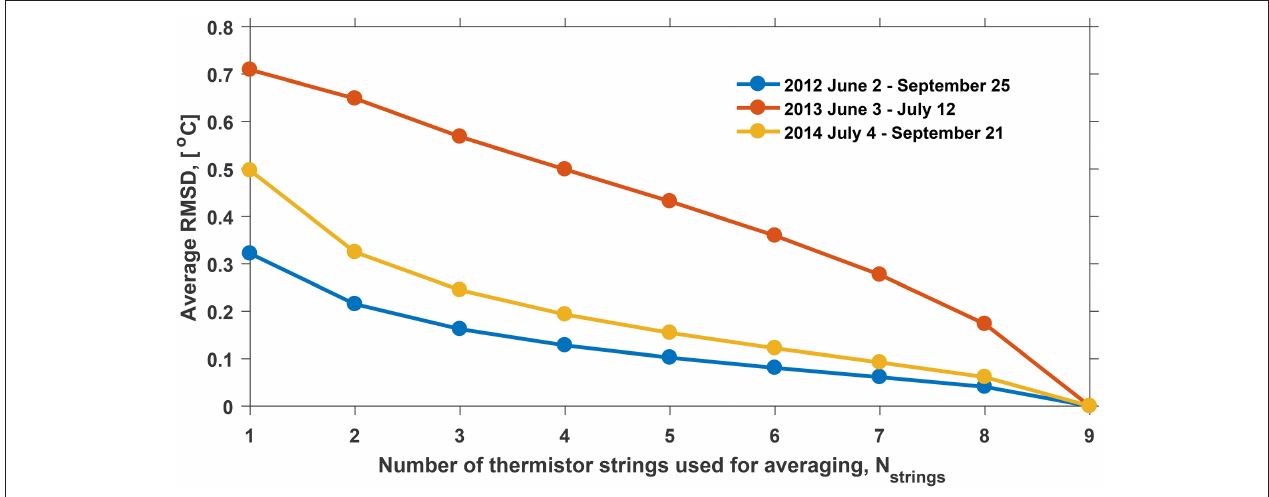
FIGURE 9 | Sensitivity of the measurements of subsurface temperature evolution during the summer period to the number of thermistor strings ( N strings ) expressed as the averaged RMSD between the reference dataset ( N strings = 9) and averages of different number of thermistor strings ( N strings =